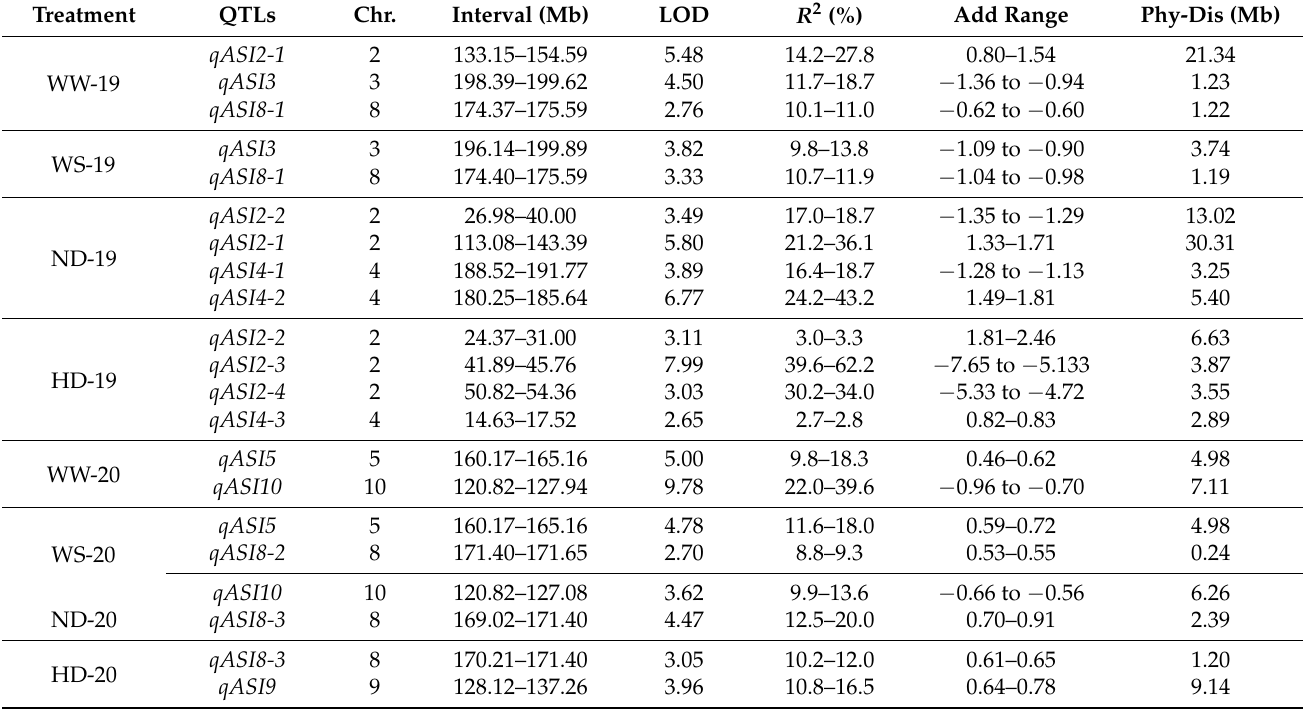
Table 4. QTLs identified for ASI under two water regimes and planting densities during 2019 and 2020.